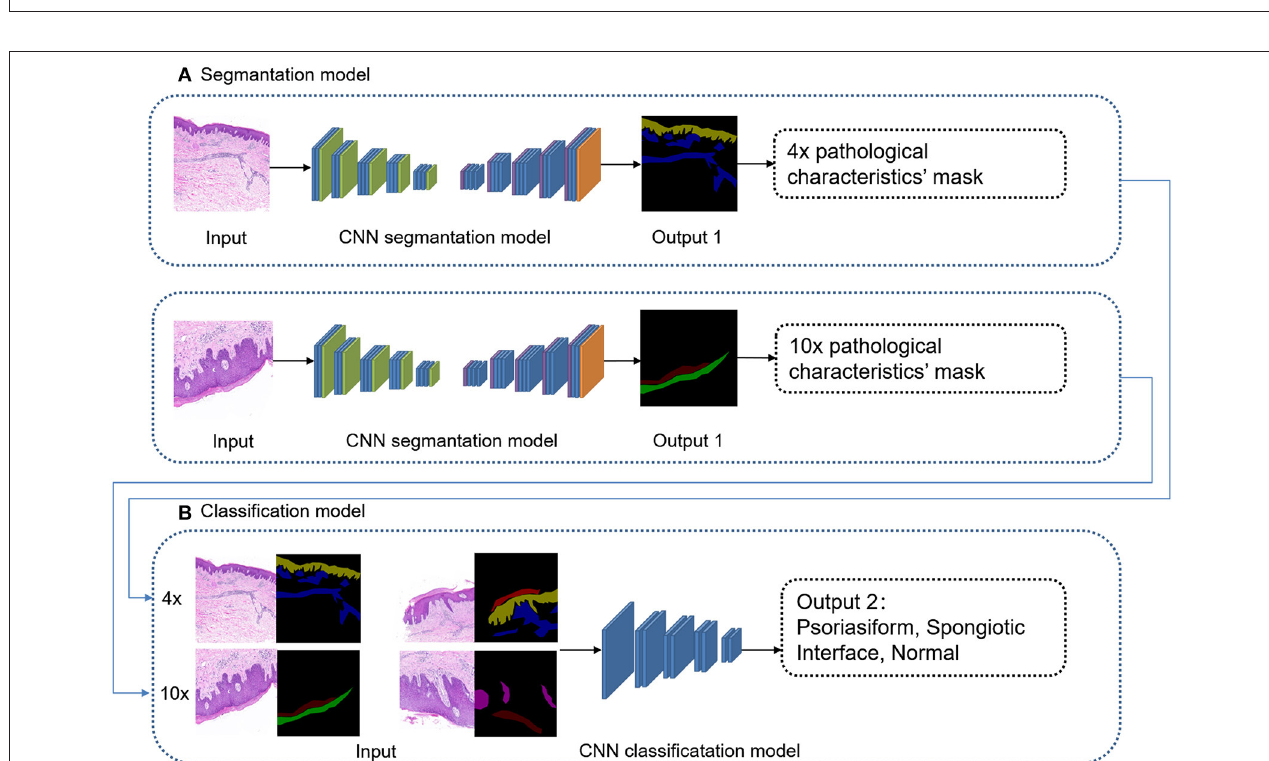
FIGURE 4 | Cascaded deep learning model of cascaded pathological characteristics recognition and subtype